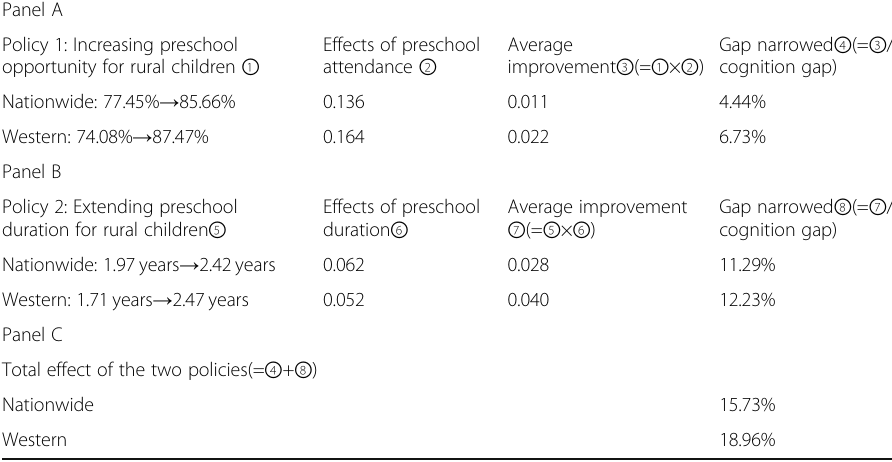
Table 5 The effects of policy simulation Panel